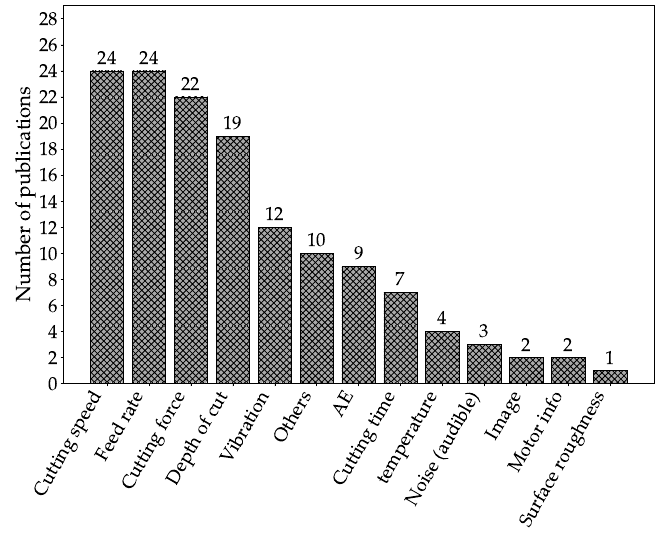
Figure 9. Repartition of inputs for ANN